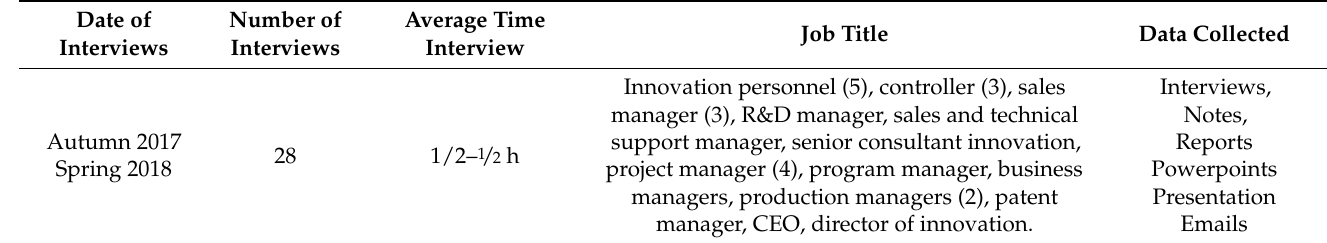
Table 1. Details of Case